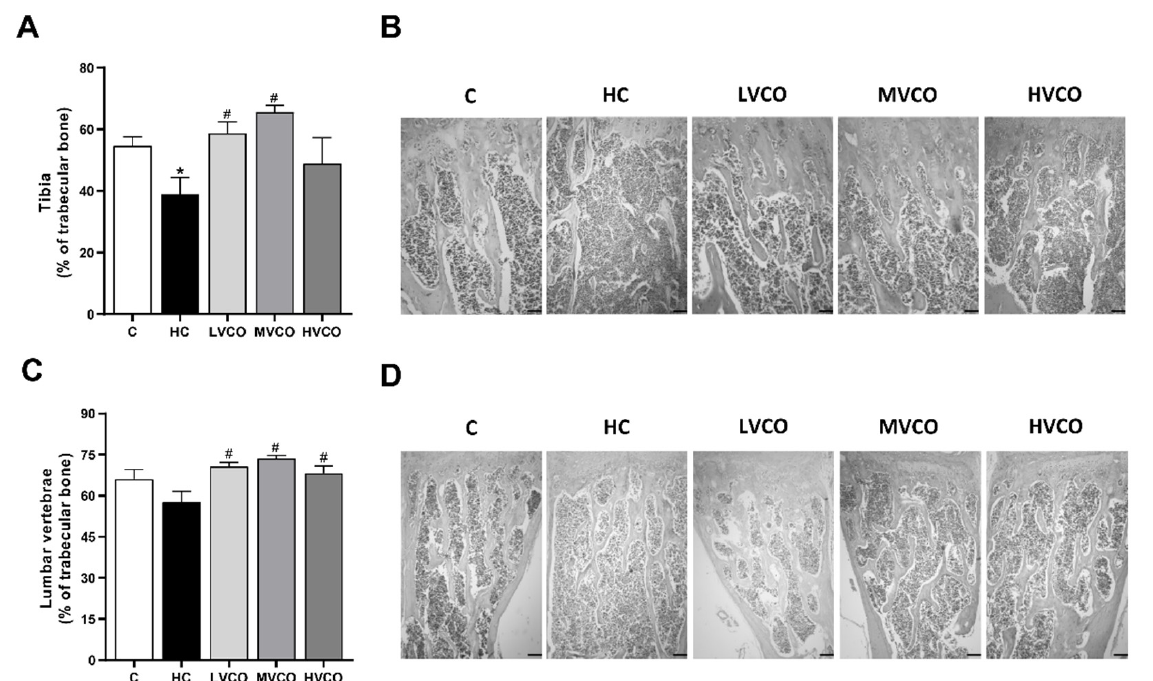
Figure 2. Effect of the HC diet and VCO supplementation on the percentage of trabecular bone in the tibia and lumbar vertebrae. ( A ) The trabecular bone area and ( B ) histological sections of the proximal tibia (scale bars represent 100 µ m). ( C ) The trabecular bone area and ( D ) histological sections of lumbar vertebrae (scale bars represent 100 µ m). Analyses were performed in mice fed a chow diet, high refined carbohydrate-containing (HC) diet, and HC diet supplemented with 1000 mg/kg (LVCO), 3000 mg/kg (MVCO), or 9000 mg/kg (HVCO) of body weight of virgin coconut oil (VCO). Values are means ± SEM ( n = 8). * compared with the control (C) group ( p < 0.05); # compared with HC group ( p < 0.05).